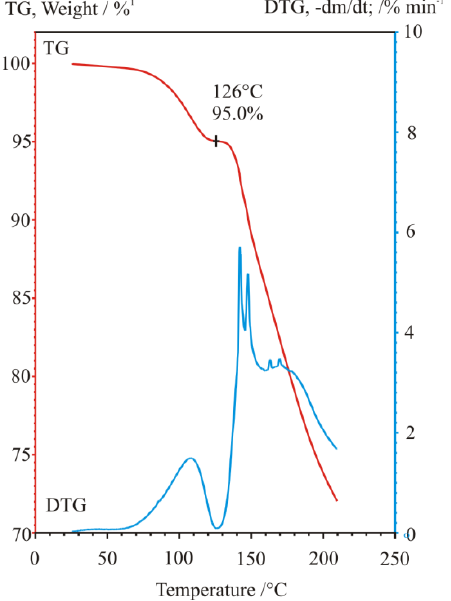
Figure 29. Thermogravimetric (TG) and derivative thermogravimetric (DTG) curves of weight loss and weight loss rate curves, respectively, of the air dried diastereomeric salt, during a TG-EGA-FTIR spectroscopic evolved gas measurement at heating rate of 10 °C/min. (Figure based on Ref. [15]).